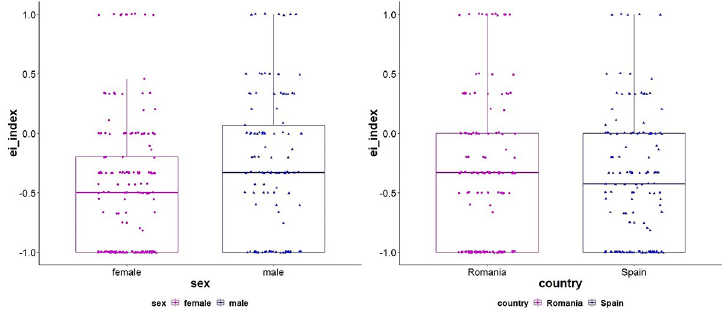
Fig 5. Boxplots illustrating individual distributions of EI-index scores split by sex and residence. For every study participant who provided referrals, an E-I index score was computed, either taking into account sex or place of residence. E-I index is computed by a simple formula: for a specific participant the difference between the number of ties between groups and within group is divided up to the sum of ties (e.g., for a female participant, the difference between her ties sent to males and her ties sent to other females is divided up to the total number of ties).